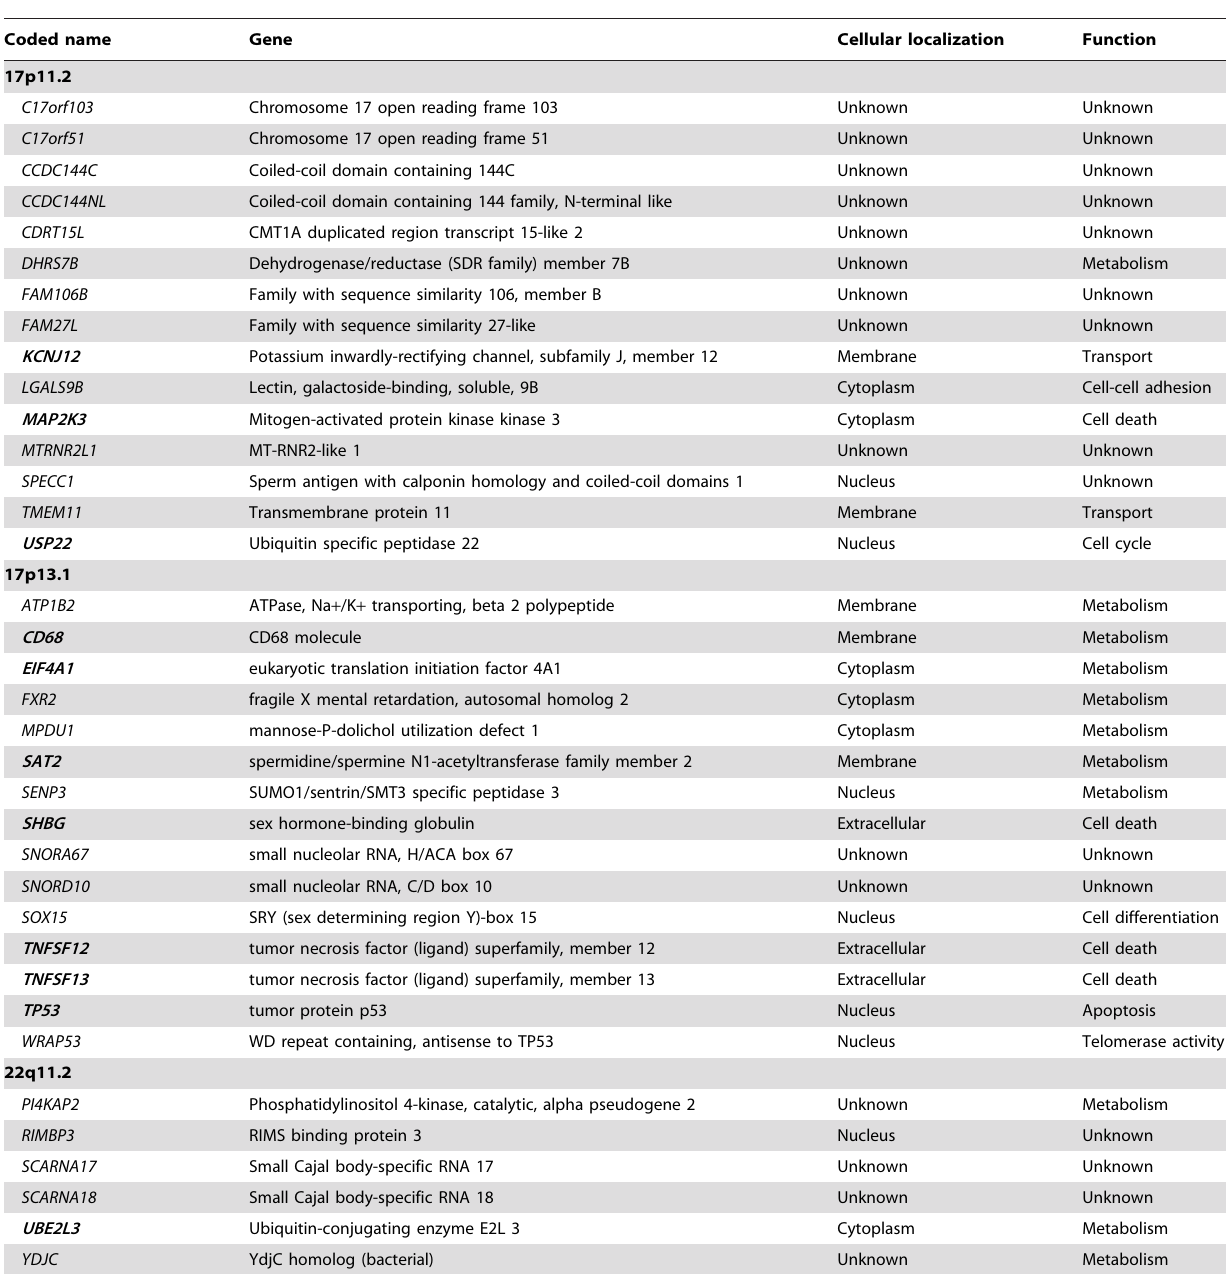
Table 3. List of genes encoded at chromosomal regions identified as being deleted by iFISH probes directed against the 17p11.2 (20156497 bp to 22975771 bp), 17p13.1 (7449445 bp to 7594642 bp) and 22q11.2 (21852397 bp to 21984023 bp) chromosomal regions: gene name, cell localization and